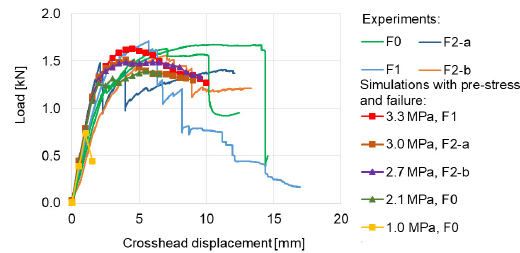
Figure 16. Load vs. crosshead displacement for the results of CT test experiments and simulations calcu- lated with θ c = 1 . 6° and different pre-stress levels.